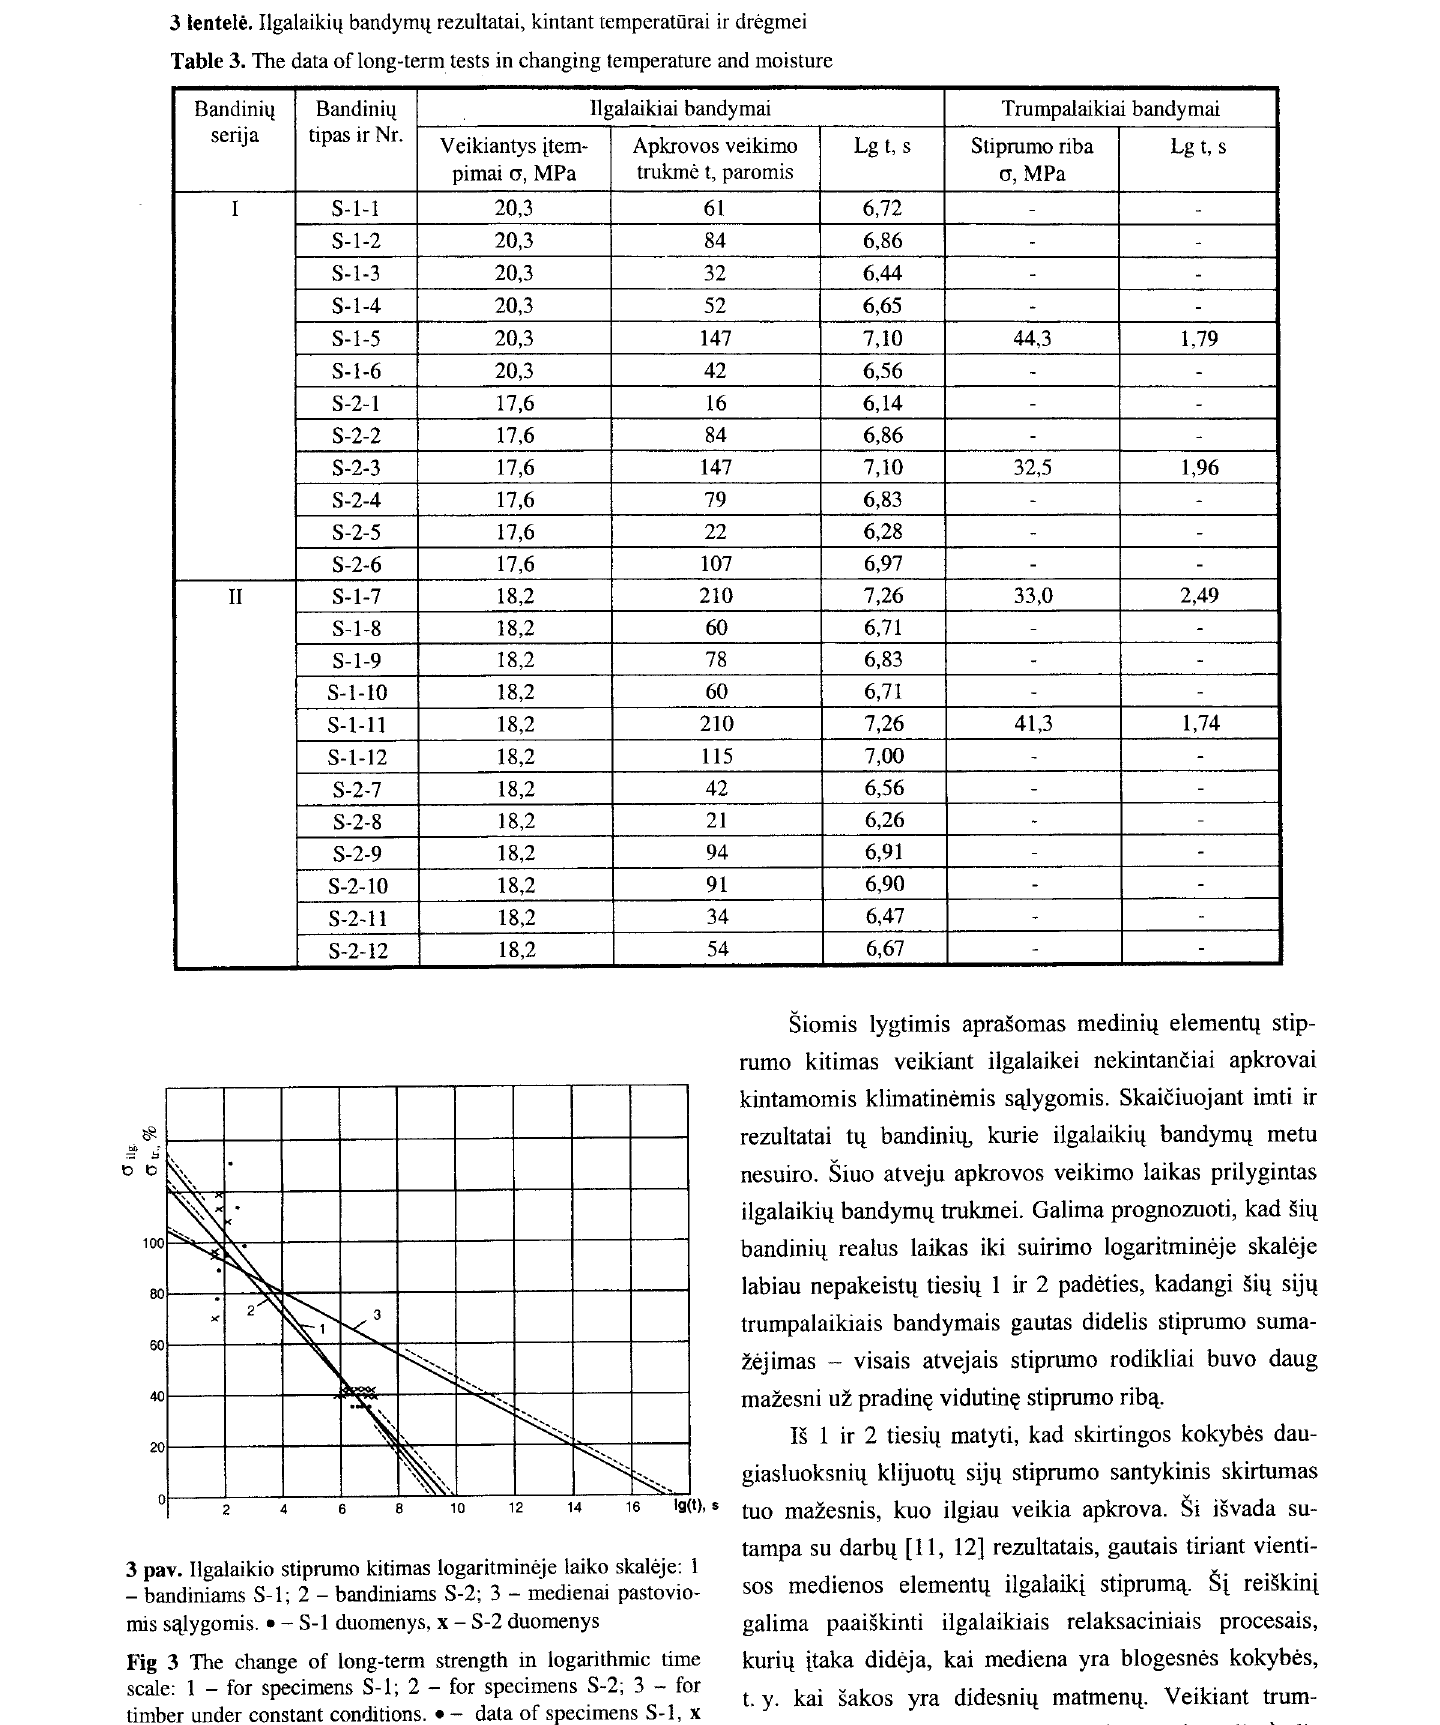
Table 3. The data of long-term tests in changing temperature and moisture Bandinil! Bandinil! serija tipas ir Nr.